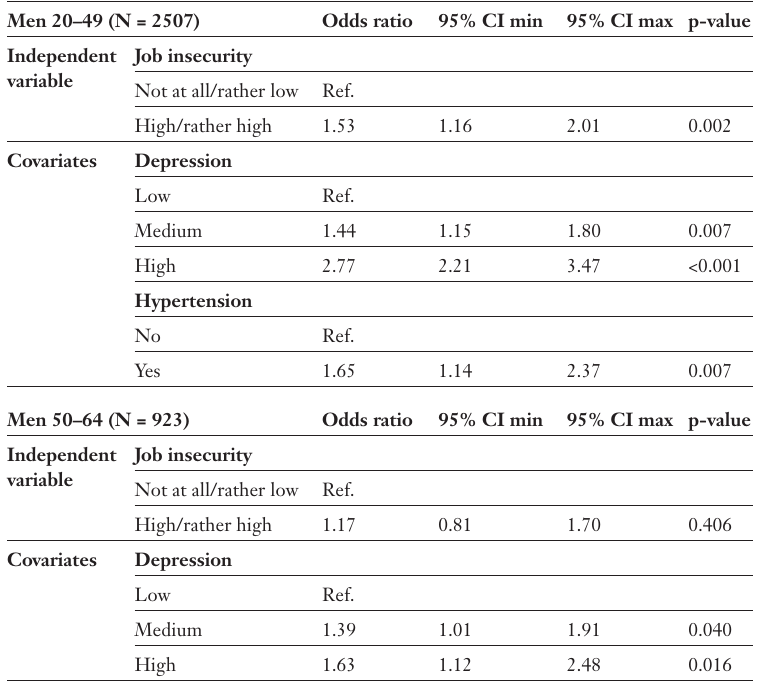
Men: logistic regression of predictors of decrease in sexual desire